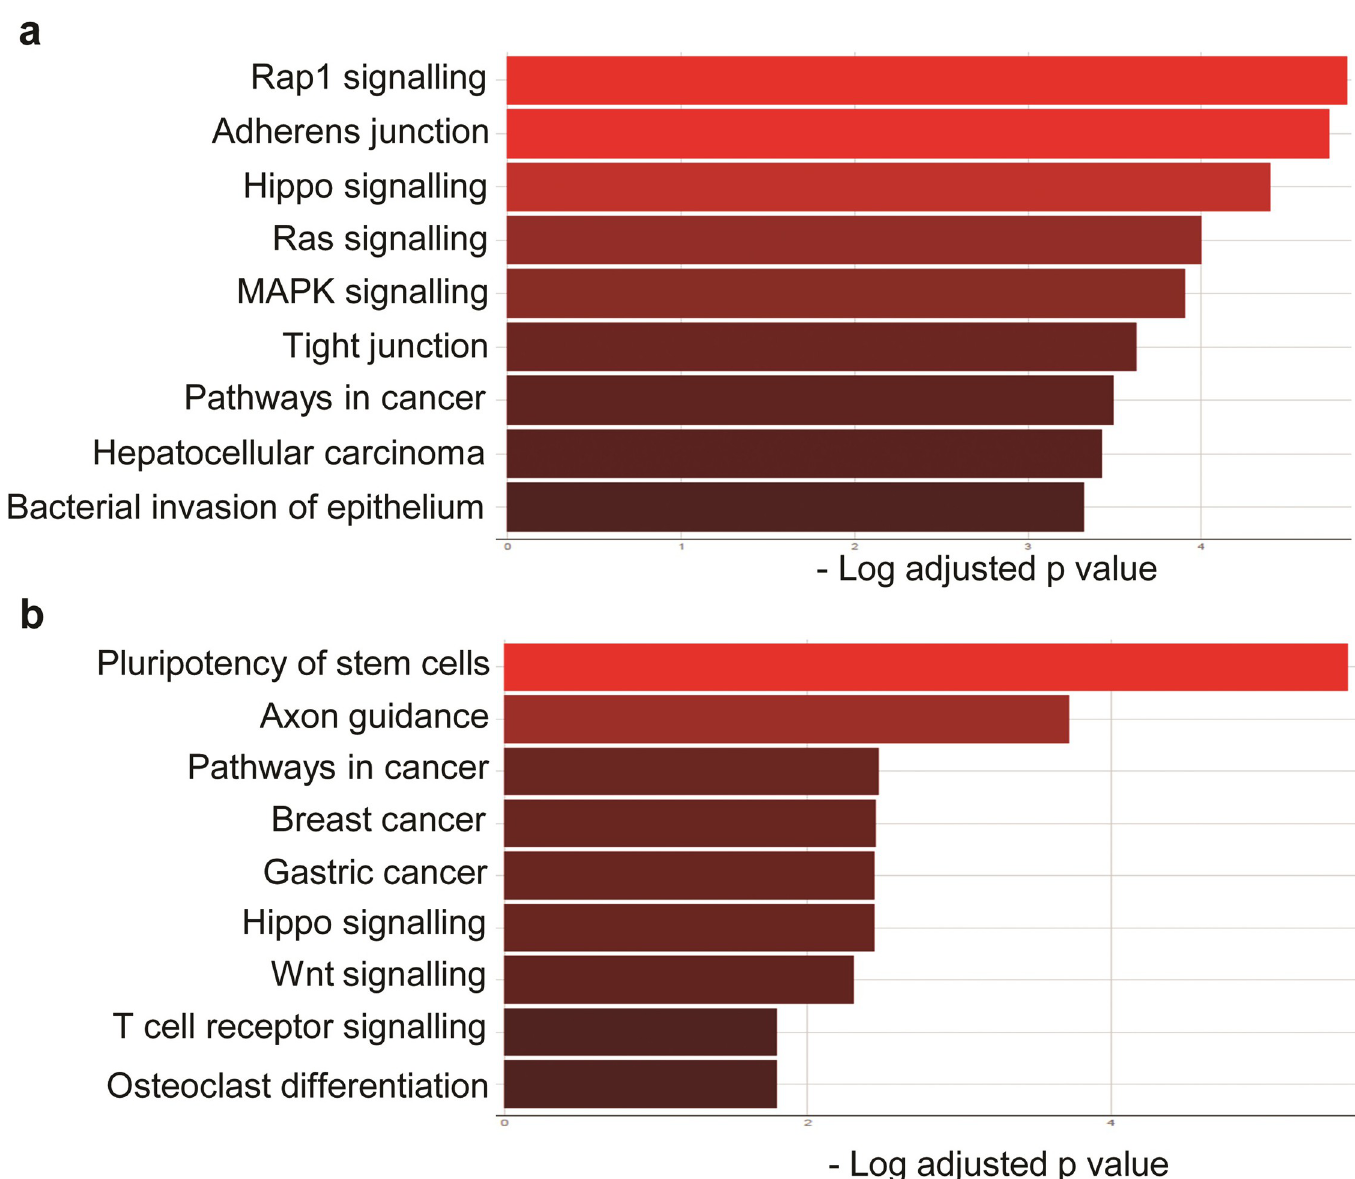
Fig 3. MyomiRs and certain miRNAs from DLK1-DIO3 locus constitute a fraction of normomiRs. ( a ). KEGG analysis of genes predicted to be targeted by myomiRs. The gene targets of myomiRs were predicted using TargetScan and the GO analysis was performed using the KEGG feature of Enrichr. ( b ). GO analysis of genes predicted by TargetScan to be targeted by miR-381, miR-411, and miR-1247. These miRNAs belong to the DLK1-DIO3 locus-embedded miRNA